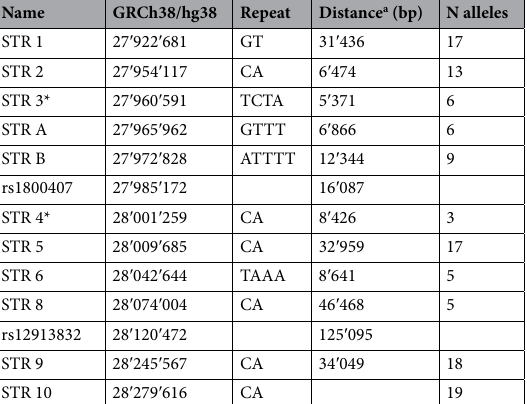
Table 1. STR marker list. a Position from UCSC Genome Browser on Human Dec. 2013 (GRCh38/hg38). *Low level of polymorphism, one allele at frequency between 94 and 100% outside